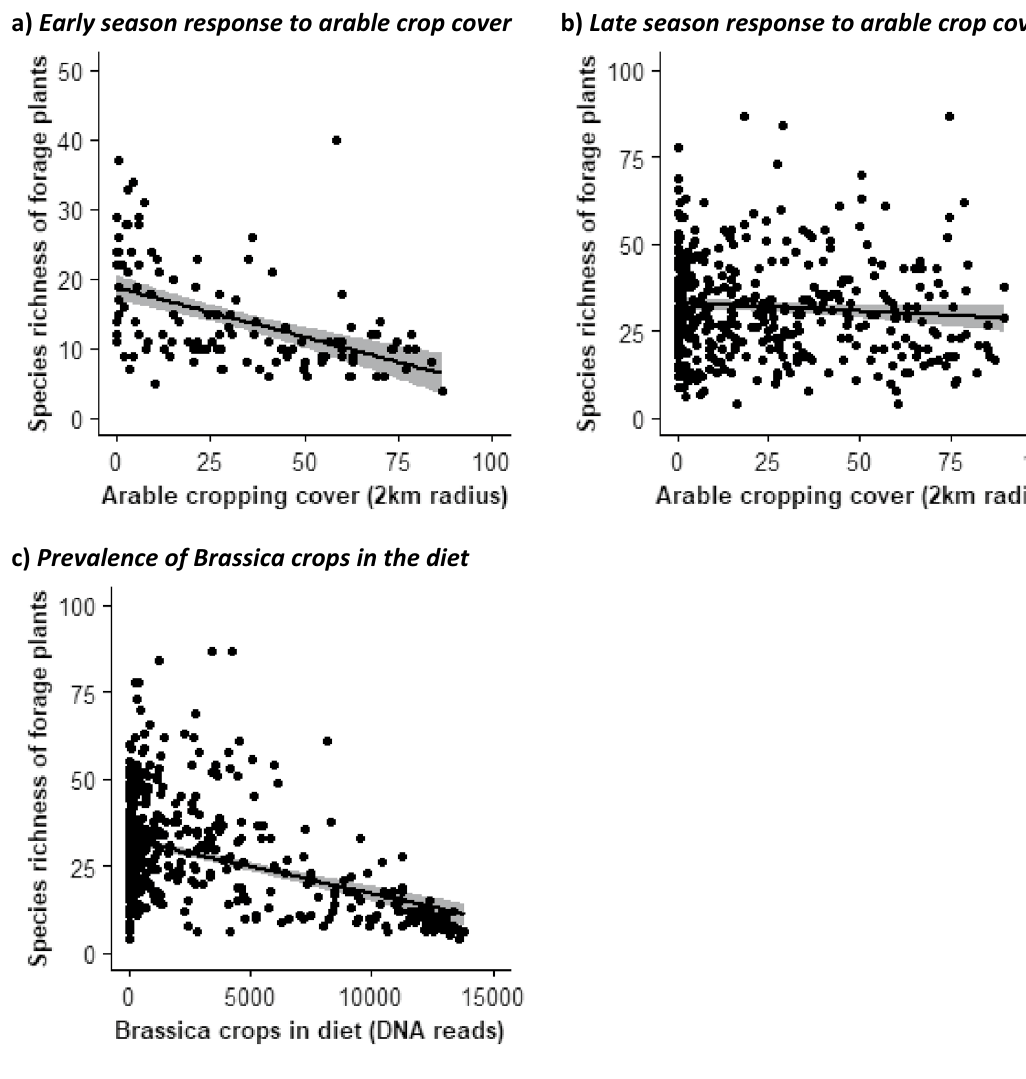
Figure 2. Effect of surrounding land use on the diet breadth (species richness of forage plants) of honeybees in Great Britain. Response of diet breadth to arable and horticultural crop cover are shown for the ( a ) early (June and before) and ( b ) late (July and after) parts of the year, as well as ( c ) to the prevalence of Brassica crops (including Oilseed rape) found in honeybee